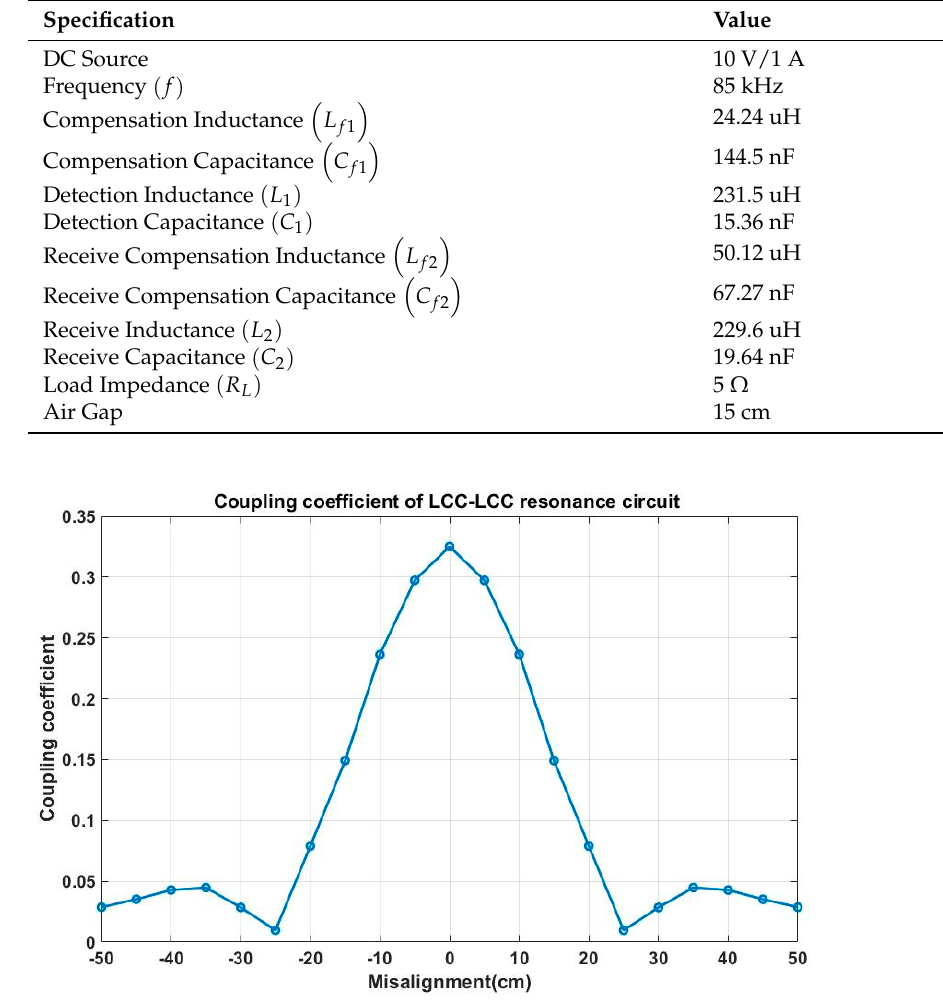
Figure 4. Measurement of coupling coefficient.